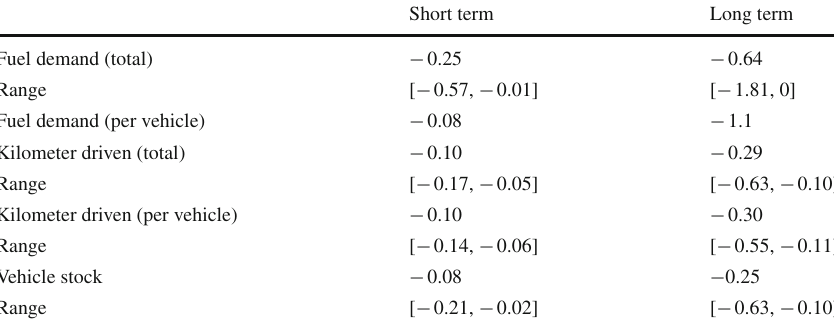
Table 3 Goodwin, Dargay and Hanly’s (2004, Table 4) summary of elasticities w.r.t fuel price